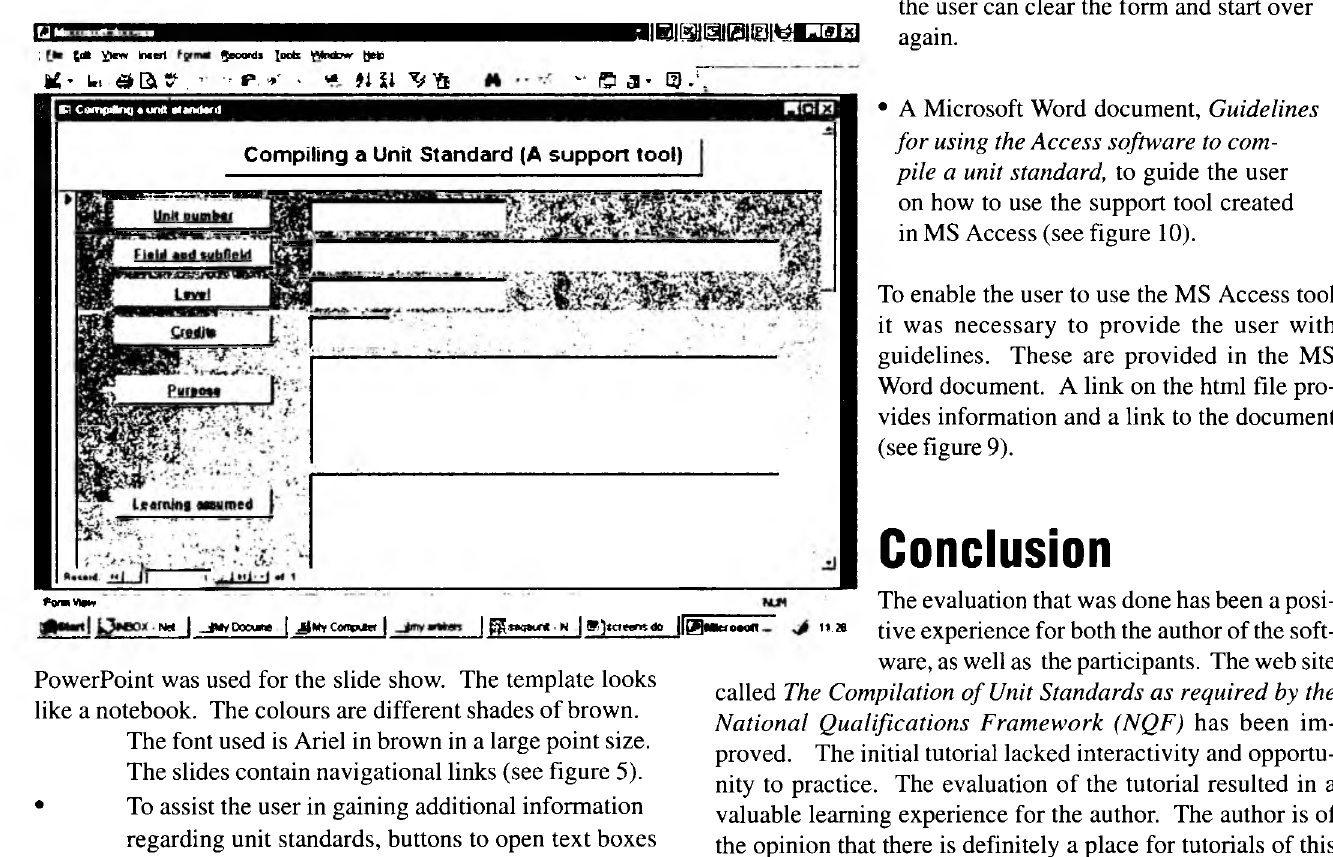
Figure 7 : MS Access tool to practice writing unit standards